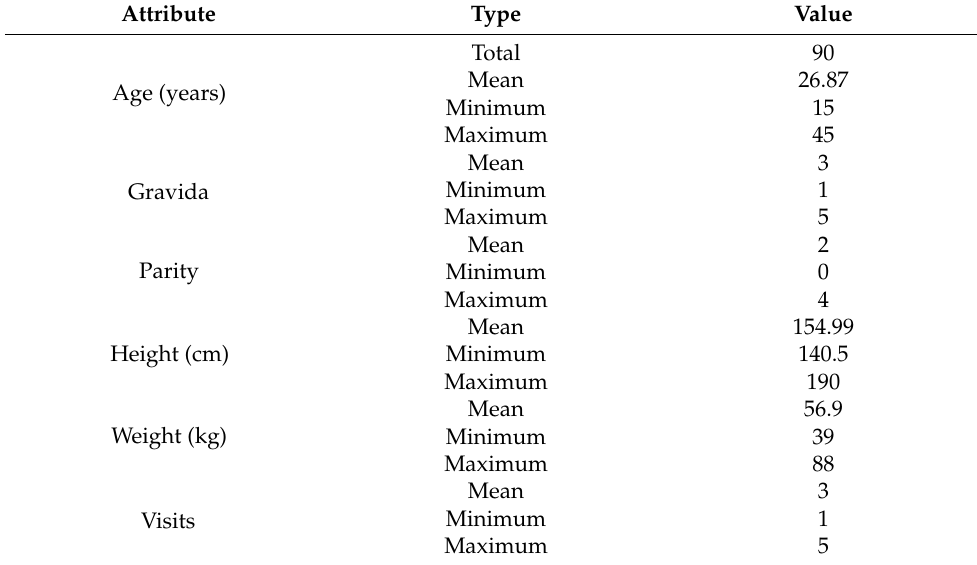
Table 3. Demographic data of the municipality of Daraga,